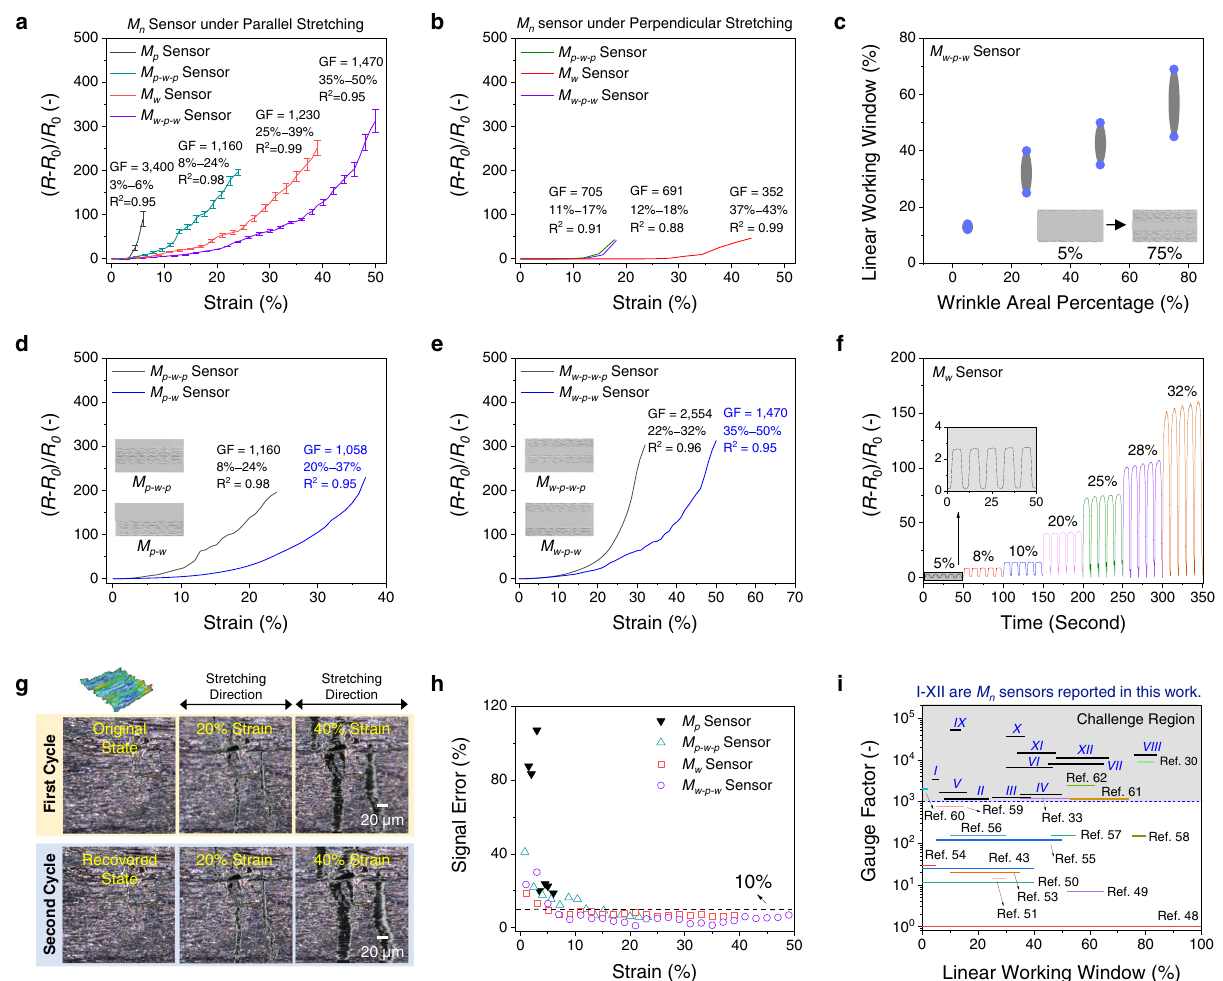
Fig. 3 | Tunable strain sensing characteristics of M n sensors through topo- graphic designs and stretching directions. a Relative resistance change ( S ε ) – strain( ε )curvesof M n sensorsunderparallelstretching.Errorbarreferstothe standard deviations, which were calculated based on three replicates. The com- position of all M n nanolayers was set at 85/10/5 (MXene/SWNT/PVA), and the thickness of all M n nanolayers was controlled at 400nm. b Relative resistance change( S ε ) – strain( ε )curvesof M n sensorsunderperpendicularstretching. c Linear working window(s) of the M w-p-w sensors with different areal percentages of wrinkle-like region(s). d Strain sensing curves of M p-w-p and M p-w sensors. e Strain